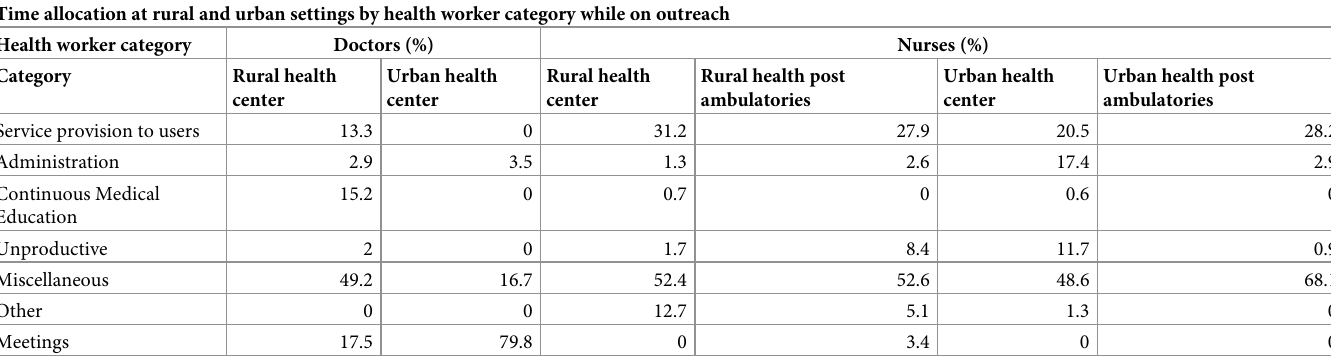
Table 4. Percentage of overall time allocation during outreach by HWs category at rural and urban settings. Time allocation at rural and urban settings by health worker category while on